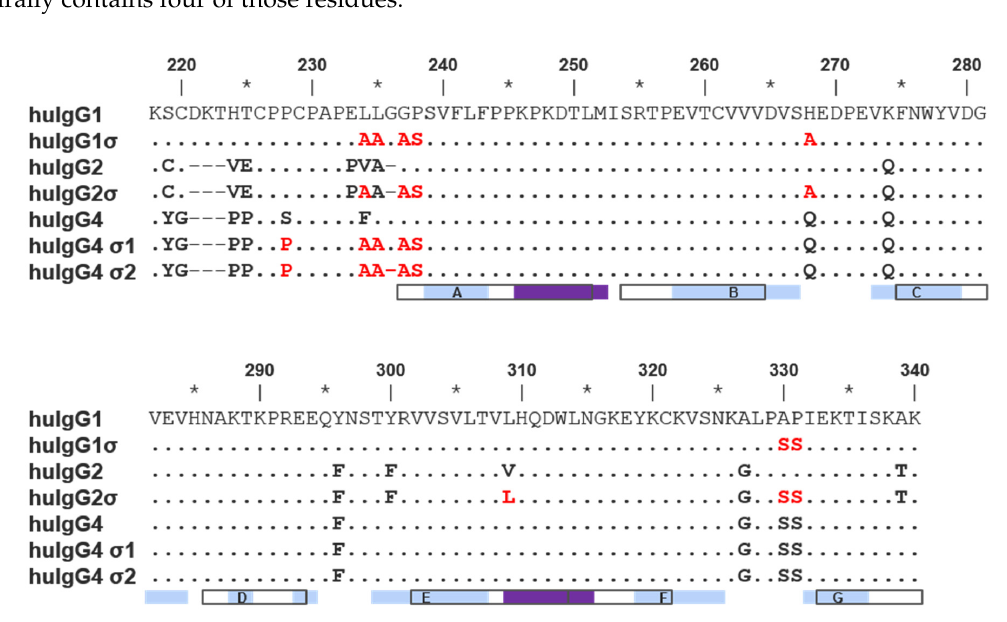
Figure 1. Alignment of hinge and constant heavy chain domain 2 (C H 2) domain amino acid sequences of wild ‐ type human immunoglobulin G1 (IgG1), IgG2 and IgG4 as well as their sigma variants. The alignment above uses EU numbering. Residues identical to wild ‐ type IgG1 are indicated as dots; gaps are indicated with hyphens. Sequence is given explicitly if it differs from wild ‐ type IgG1 or from the parental subtype for σ variants. In the latter case, sequence is colored red. Open boxes beneath the alignment correspond to International Immunogenetics Information System (IMGT) strand definitions (labeled) [39]. Light blue and purple boxes beneath the alignment correspond to the strand and helix secondary structure assignment for wild ‐ type IgG1 in the Protein Data Bank (PDB) 3AVE (chain A) [40]. Residues 267–273 form the BC loop and 322–332 form the FG loop.